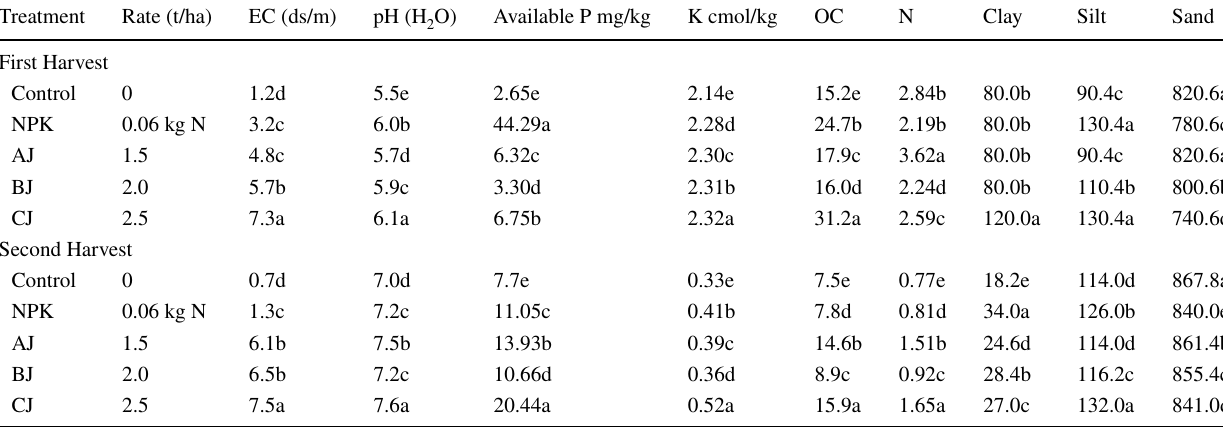
Table 4 Effects of fertilizer types on some soil chemical and physical properties at harvest during the first and second planting